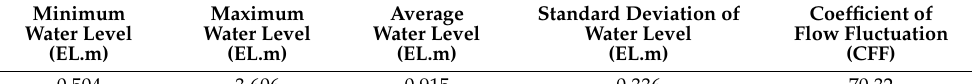
Table 3. Statistical characteristics of water levels at the Hangang Bridge Station (period: 2018–2020).